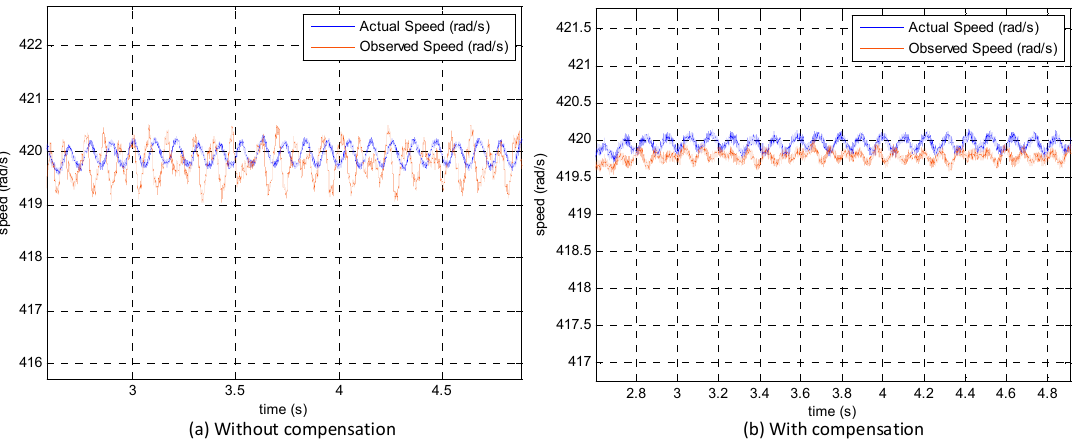
Figure 17. The experimental results of actual speed and observer speed at 420 rad/s.